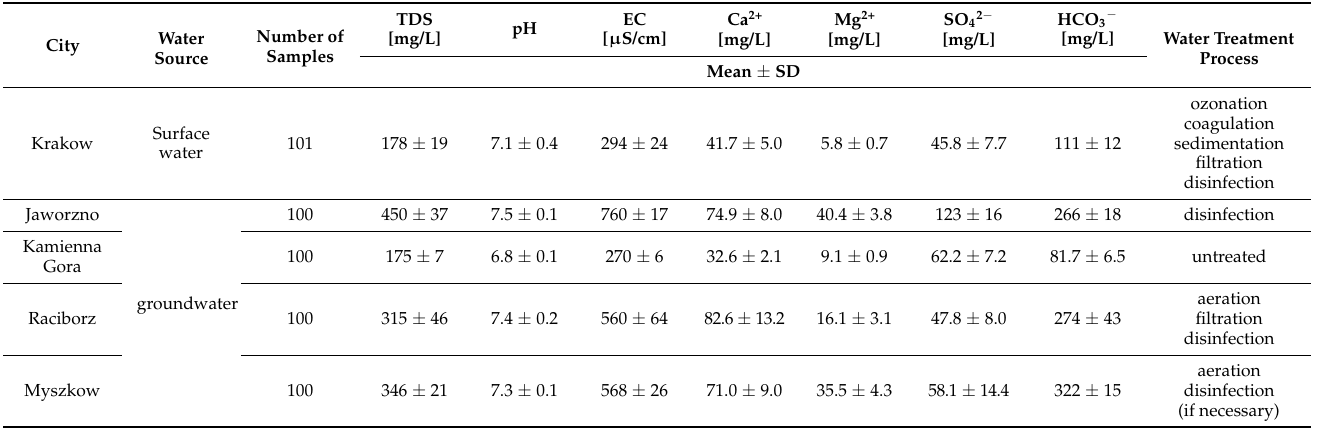
Table 2. Basic water parameters.